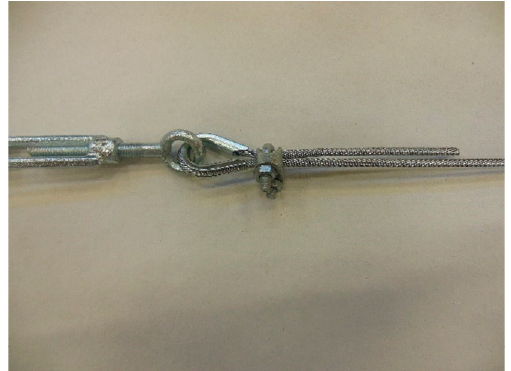
Figure 28. Specimen 3: Flemish eye closed by 1 clip.